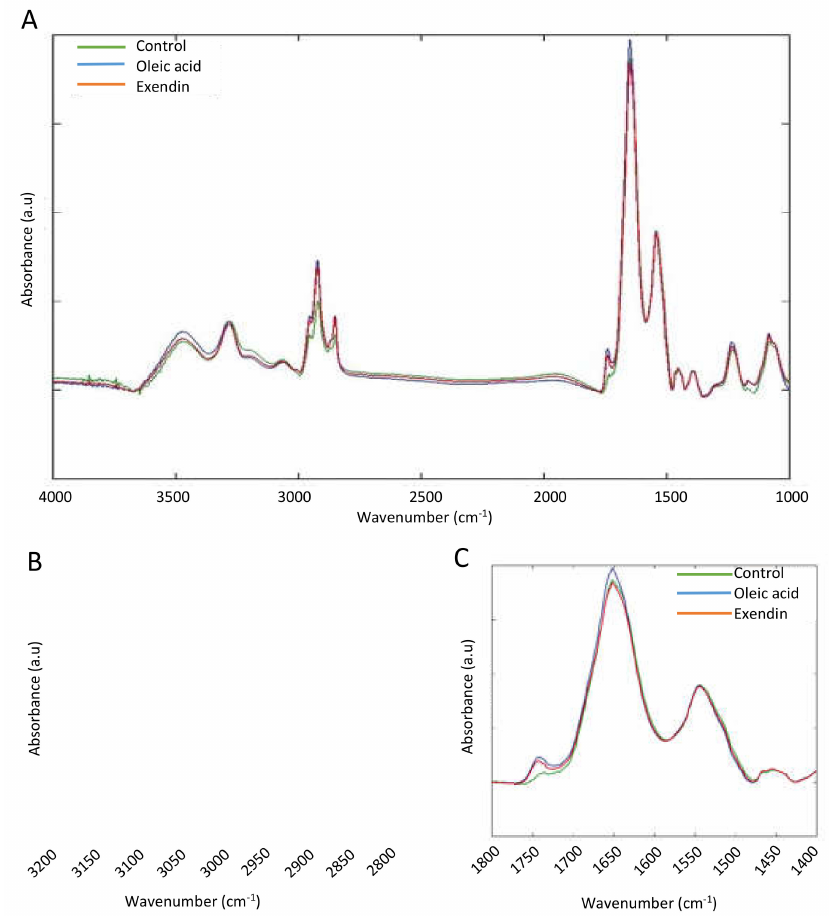
Figure 2. ( A ). Average full FTIR spectra of untreated HepG2 cells (green line), steatotic HepG2 cells (blue line), and steatotic HepG2 cells treated with Exendin-4 (red line). ( B ) Close-up of the FTIR spectra of the lipid region in the frequency region of 3200–2800 cm − 1 . ( C ) Close-up of the protein region in the frequency region of 1800–1400 cm − 1 . Each of the three spectra is the average of all of the spectra collected from three different experiments for each